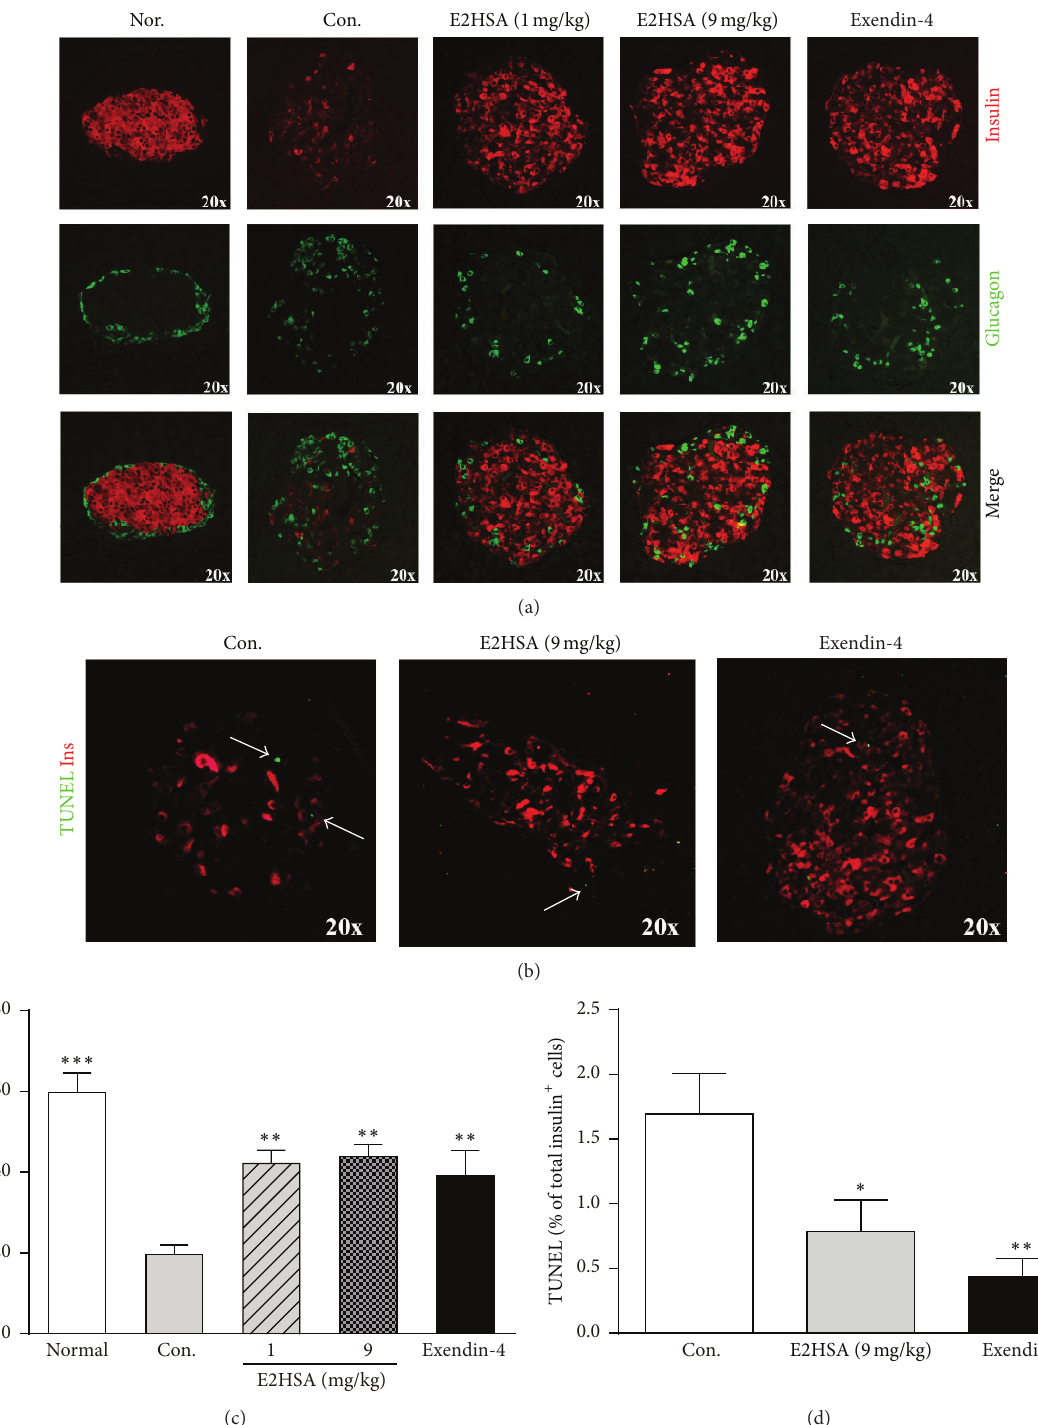
Figure 7: Chronic treatment with E2HSA normalized islet morphology, increased 𝛽 -cell area, and inhibited 𝛽 -cell apoptosis in spontaneous type 2 diabetes db/db mice. (a) Immunofluorescence double staining with anti-insulin and anti-glucagon antibodies on pancreatic sections. (b) TUNEL assay on 𝛽 -cells costained with anti-insulin antibodies. Representative images are shown. (c) Total 𝛽 -cell area as percentage of total islet areas ( 𝑛 = 5 ). (d) Percentage of TUNEL positive 𝛽 -cells in insulin positive cells ( 𝑛 = 3 per group). Data are expressed as mean ± S.E.M. ∗ 𝑃 < 0.05 and ∗∗ 𝑃 < 0.01 versus